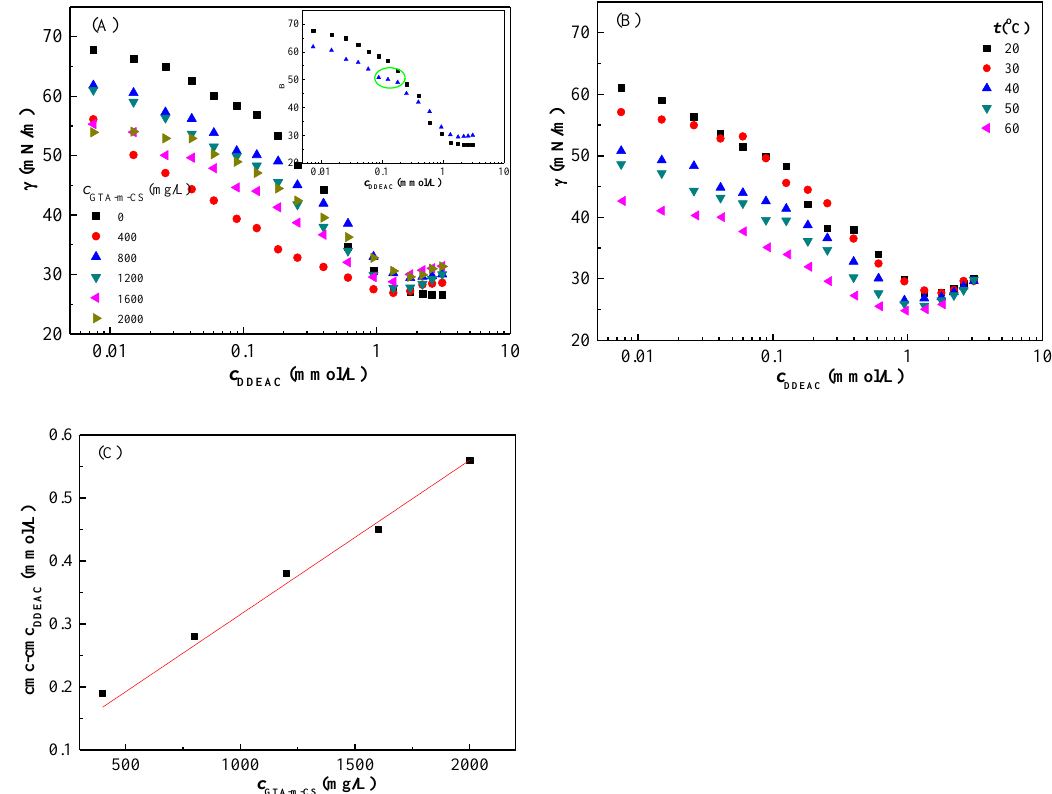
Figure 2. Plots of surface tension of GTA-m-CS/DDEAC system with different concentration of GTA-m-CS at 20 ◦ C ( A ), with GTA-m-CS concentration of 1200 mg/L with different temperature ( B ) vs. DDEAC concentration, and linear relationship between cmc-cmc DDEAC and c GTA-m-CS ( C ). There are two platforms on GTA-m-CS/DDEAC curves, as shown in the insert of Figure 2A (green circle), which is different from that of DDEAC. The initial concentration of the first platform is critical aggregation concentration (cac), indicating the beginning of the interaction between GTA-m-CS and DDEAC and the formation of GTA-m-CS/DDEAC complexes [31–33]. At this platform, the DDEAC molecules adsorb on GTA-m-CS, keep- ing the surface tension almost constant. The value of cac is related to the properties of macromolecule and surfactant. The cac values of GTA-m-CS/DDEAC systems are all ca. 0.088 mmol/L. The formation of polymer/surfactant complexes has been confirmed by transmission electron microscopy and steady shear rheological methods [34]. After the saturated adsorption of DDEAC on GTA-m-CS molecules, the DDEAC molecules continue to adsorb on the solution surface, reducing surface tension until their adsorption on solution surface is saturated. The concentration corresponding to the satu- rated adsorption on surface is critical micelle concentration (cmc), and the corresponding surface tension is equilibrium surface tension ( γ cmc ). With a further increase of DDEAC concentration, the micelles are formed. The cmc and γ cmc values of GTA-m-CS/DDEAC system are listed in Table 1, both of which increase with GTA-m-CS concentration. It is ascribed to the hydrophobic interaction between GTA-m-CS and DDEAC [33]. At a high concentration of GTA-m-CS, the GTA-m-CS molecules affect the adsorption and close arrangement of DDEAC molecules on the surface, inhibiting the further reduction of equilibrium surface tension ( γ cmc